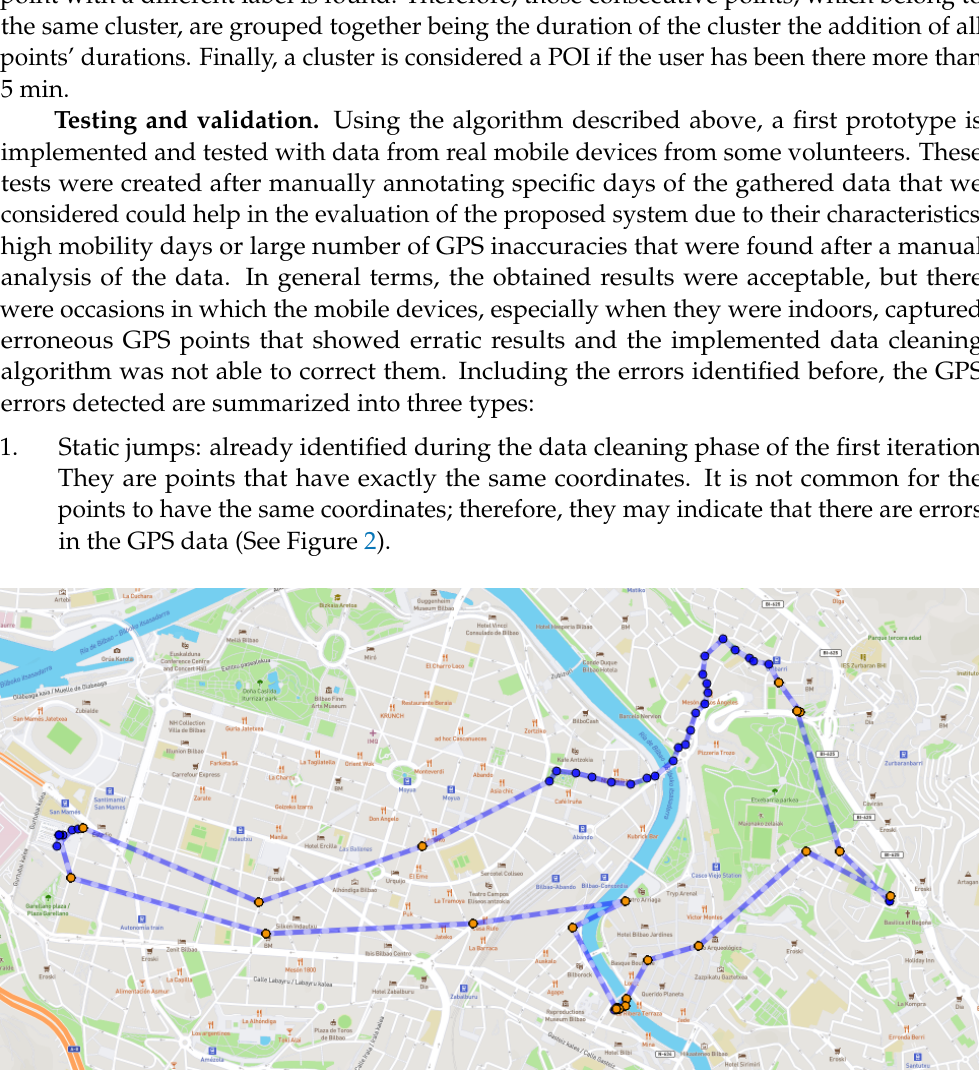
Figure 2. Yellow points are static-jumps. Each of those points are really ten points with the same